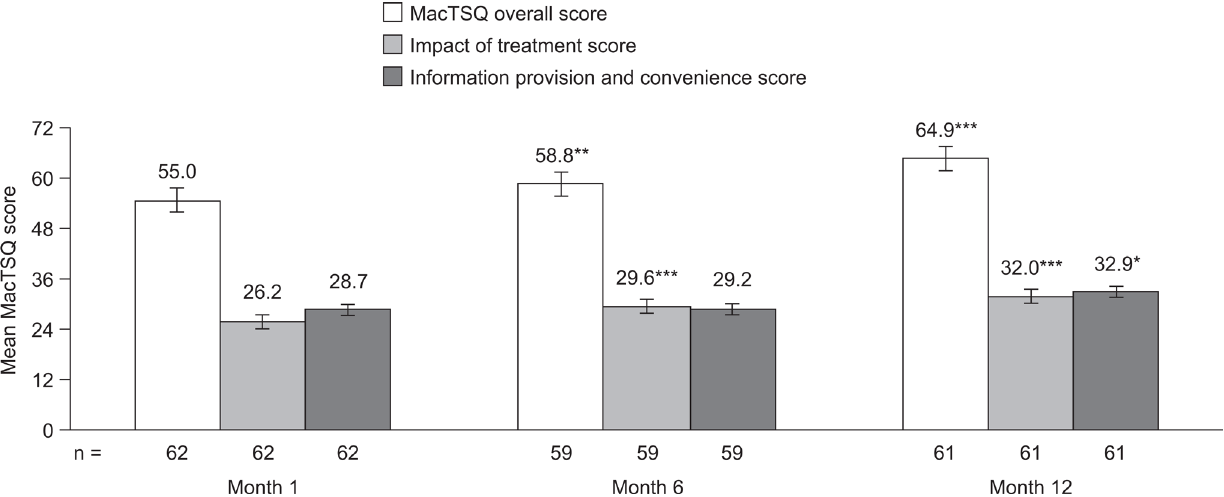
Fig 1. Mean MacTSQ total score and subscale scores. Data are shown as mean ± standard error. * p < 0.05 vs month 1. ** p < 0.01 vs month 1. *** p < 0.001 vs month 1. MacTSQ, Macular Disease Treatment Satisfaction Questionnaire.